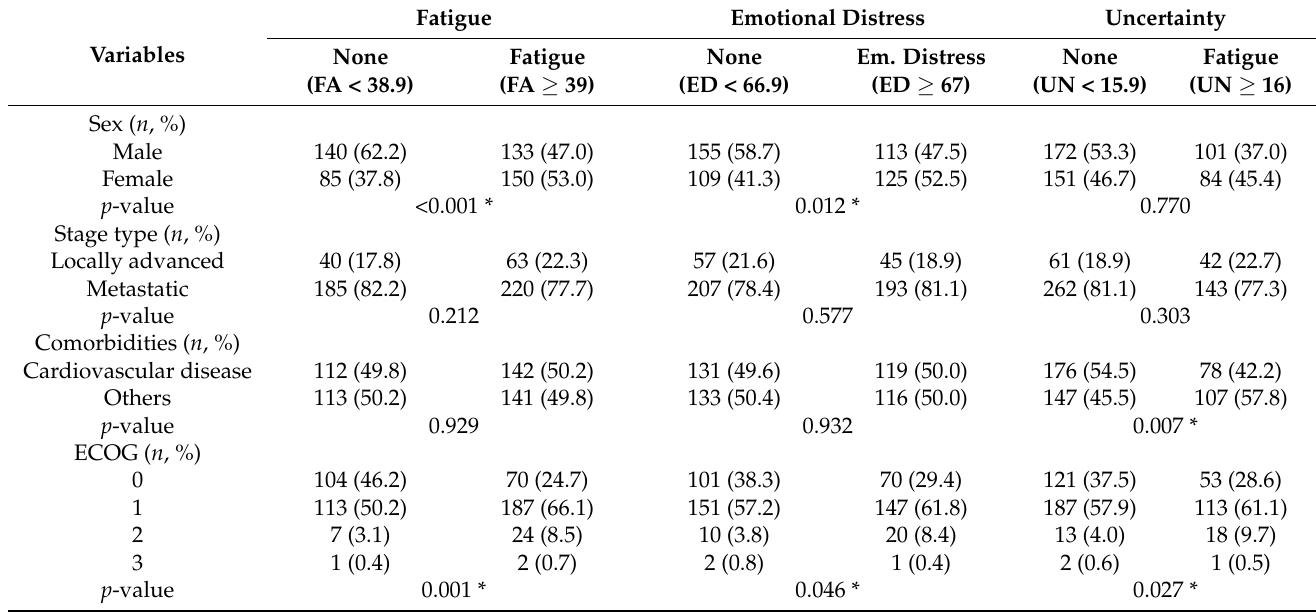
Table 2. Fatigue and emotional distress across sexes and stage